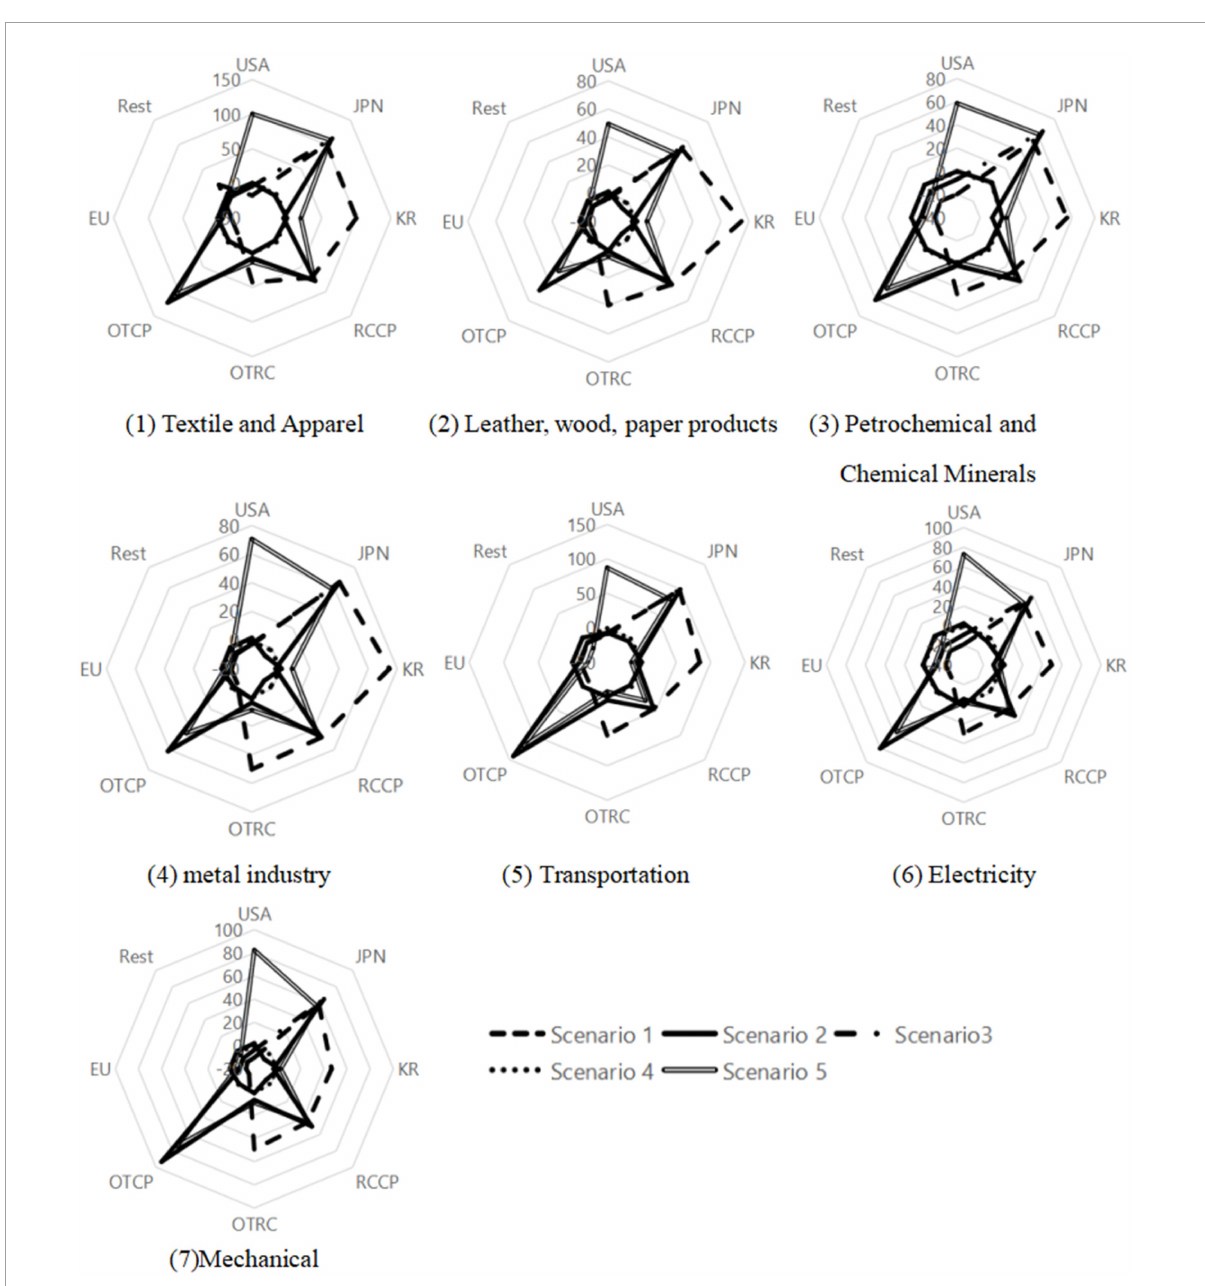
FIGURE2 Impact on imports of China’s manufacturing industries (Manufacturing industries classification is from the 10th edition of the GTAPAgg